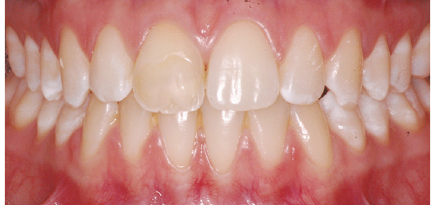
Figure 5: Discoloration of the fractured tooth crown after 10 years.